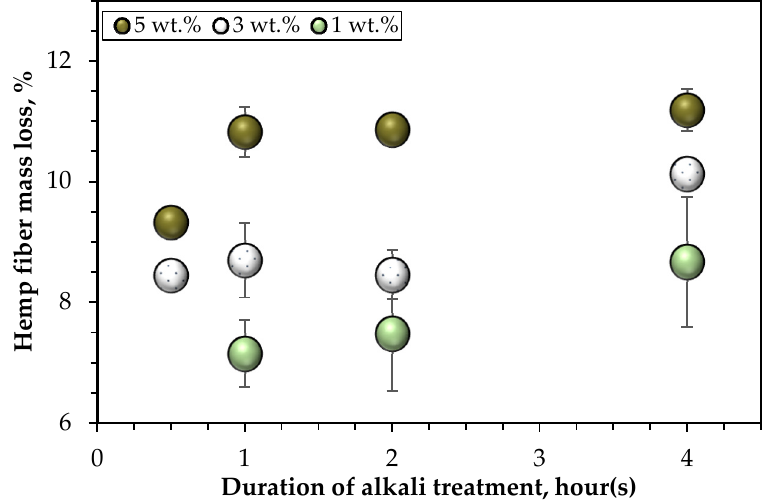
Figure 5. Hemp fiber mass loss following alkali (NaOH) treatment.